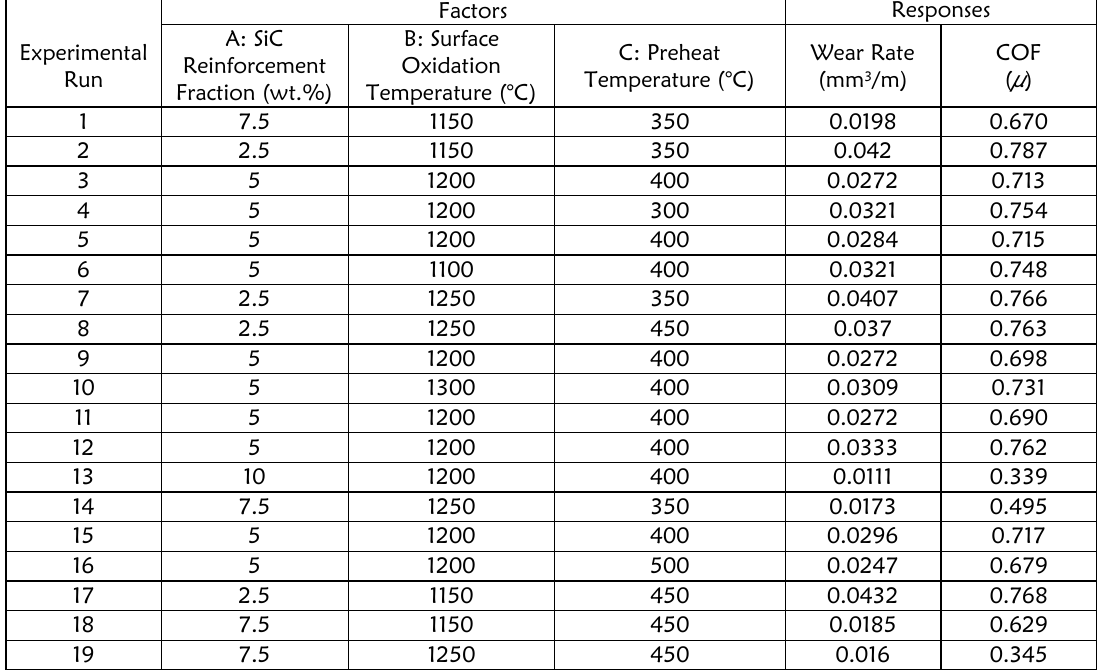
Table 4: Design matrix and responses for oxidized-SiCp reinforced AA6061 matrix composite